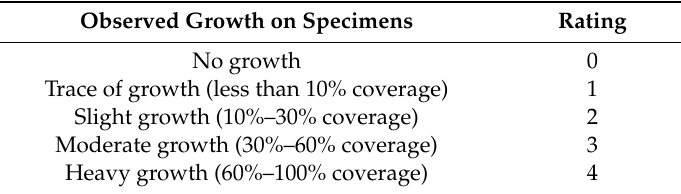
Table 3. Grading scale for visible e ff ects in antifungal test